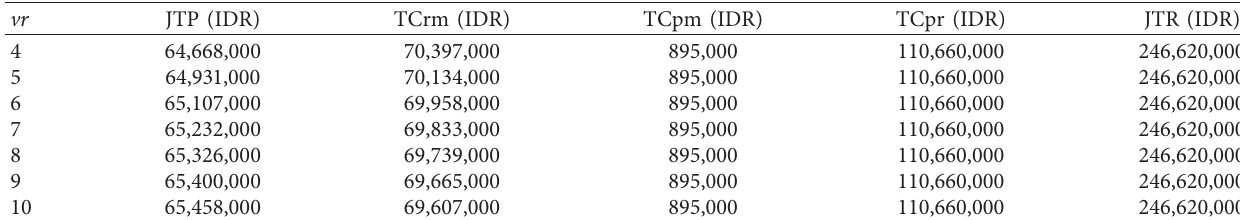
Table 11: Sensitivity analysis of the effect of vr on cost, revenue, and profit.